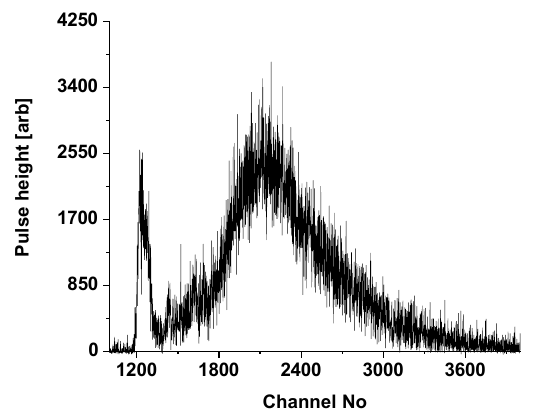
Fig. 10. Group waveform composed of 100 sequential waveforms;